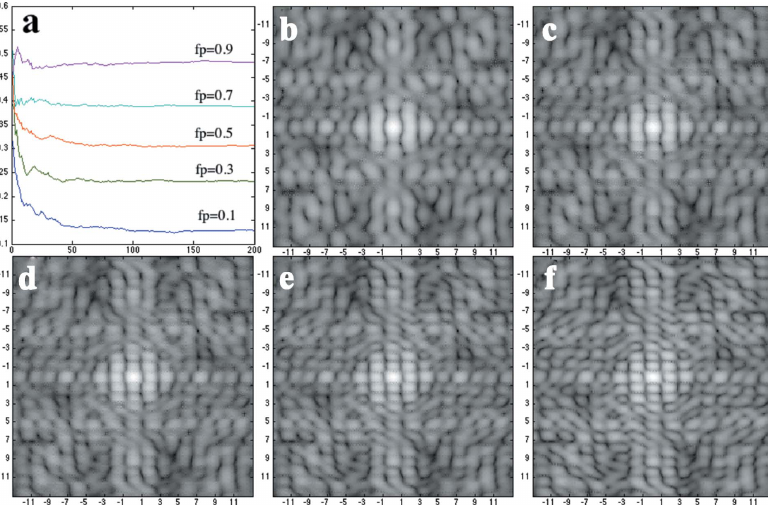
Figure 4 The recovered pattern from crystals with partial unit cells. The fractions of partial unit cell occupied boundary layer are 0.1, 0.3, 0.5, 0.7, 0.9 for ( b )-( f ), correspondingly. The R factor as a function of the number of diffraction patterns is shown in ( a ) for all five cases with the fraction of partial unit cells indicated. The recovered patterns shown in ( b ) and ( c ) are consistent with the default unit-cell scattering pattern, while the patterns shown in ( e ) and ( f ) are more similar to the scattering pattern of the alternative unit cell. The pattern shown in ( d ) is a superposition of the patterns, as the partial unit cells cover half of the crystal boundary.